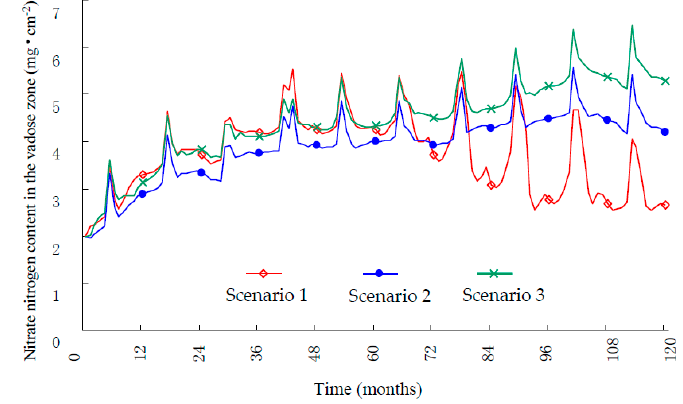
Figure 10. The nitrate nitrogen reserves throughout the vadose zone over time.